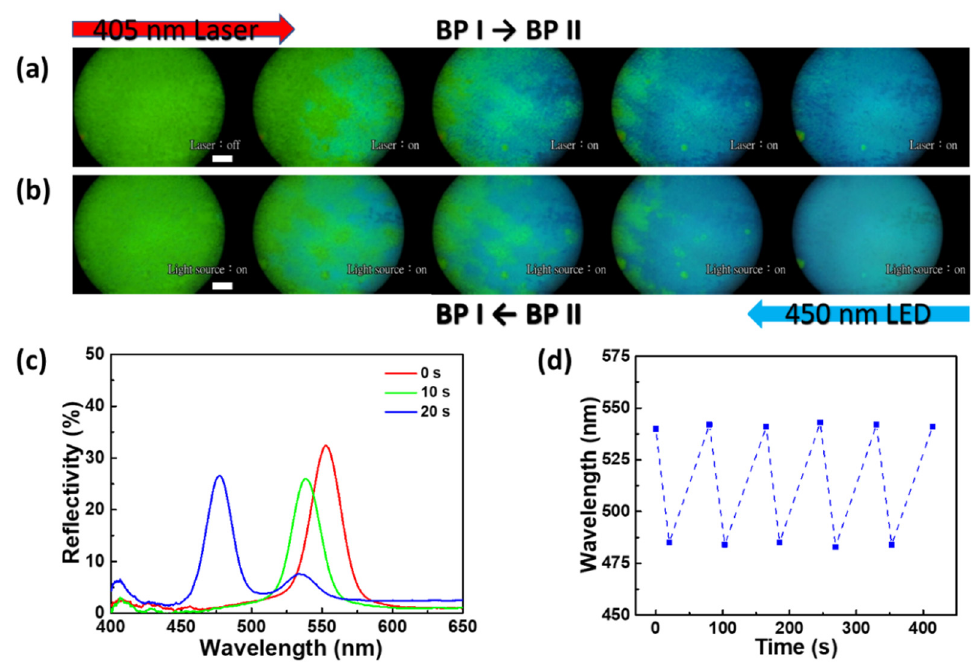
Figure 3. R-POM images of the aligned CA-BPLC sample with surface alignment during the ( a ) illumination of 405 nm laser and ( b ) 450 nm LED light source at BPI. The length of the scale bar is 100 μ m. ( c ) The optically controlled reflection spectra of the CA-BPLC sample at BPI. ( d ) Repeatability test of the optically controlled reflection between two different color regions. The temperature is fixed at 47.5 °C.